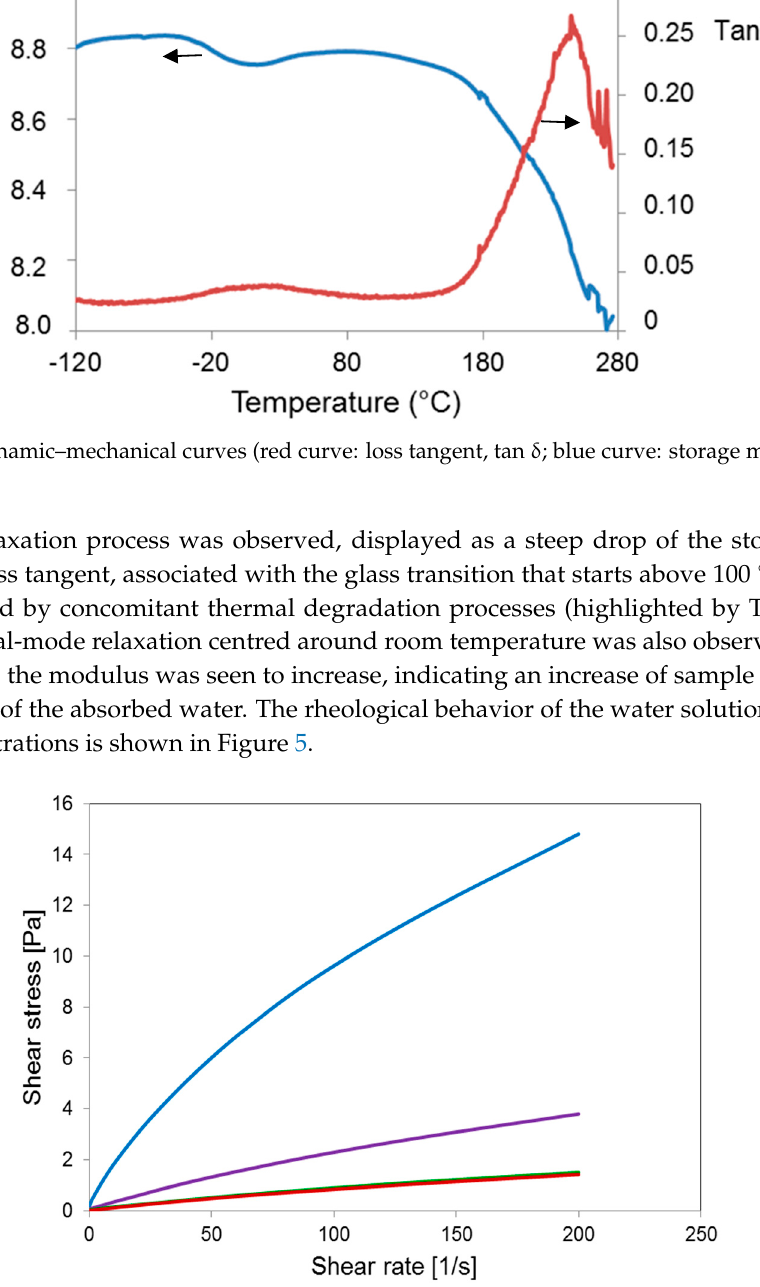
Figure 5. Shear stress vs. shear rate curves of water solutions of γ -PGA with different concentrations: 2% (blue), 0.5% (violet), 0.25% (green), and 0.125% (red).